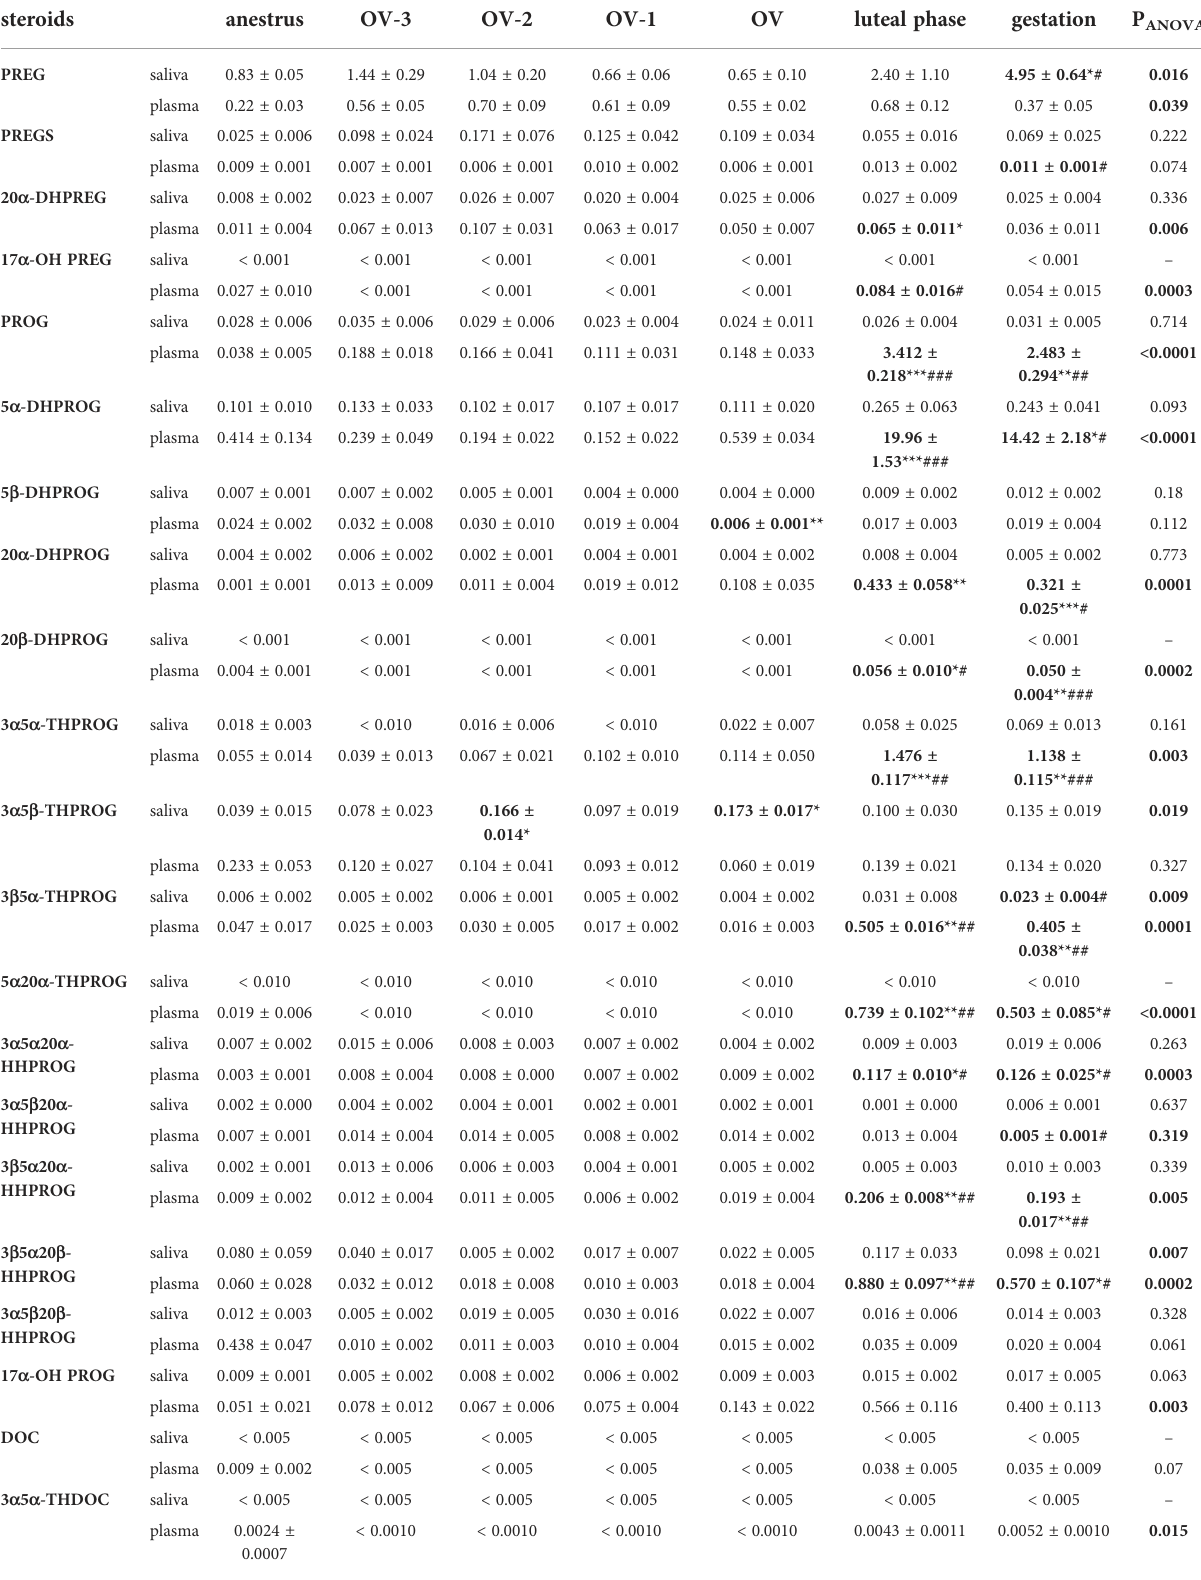
TABLE 2 Steroids pro fi ling in saliva and plasma of mare in anestrus, 3 days before ovulation (OV-3), 2 days before ovulation (OV-2), 1 day before ovulation (OV-1), the day of ovulation (OV), in luteal phase (6 days after ovulation) and during gestation (18 days after ovulation).